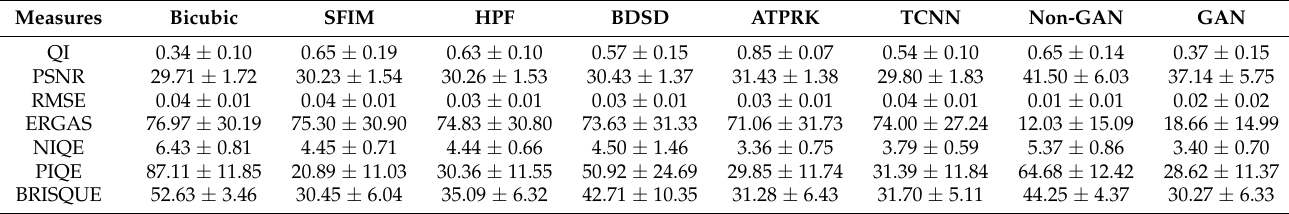
Table 4. Model performance in the real data experiment assessed by full-reference and non-reference measures. Measures Bicubic SFIM